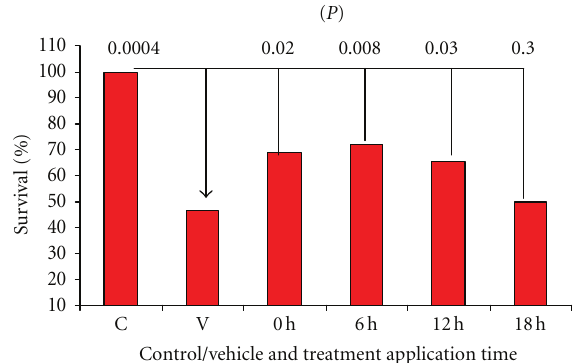
Figure 8: After 7 days of models of focal ischemia. P = Significance with regard to vehicle, indicating a significant di ff erence in the U test of Mann and Whitney. ( n = 35 per group). Dose Neuro-EPO IN 249.4 UI.